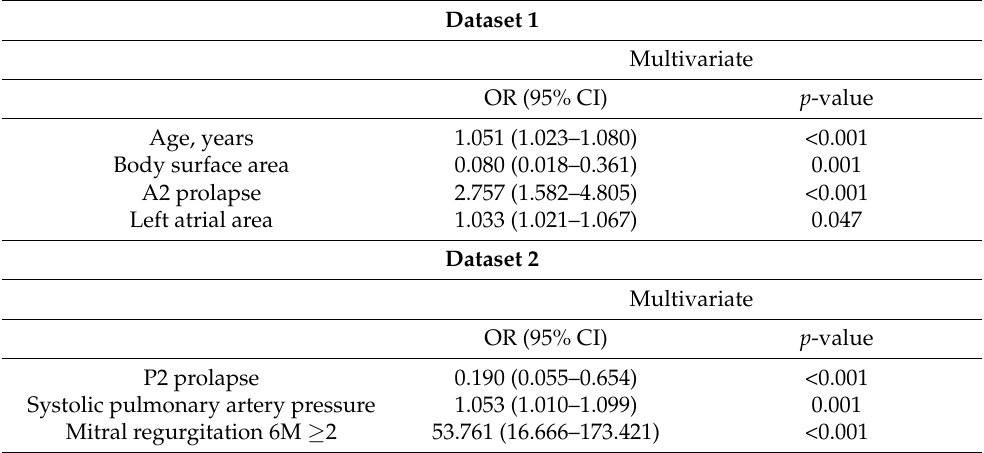
Table 3. Multivariate logistic regression analysis.